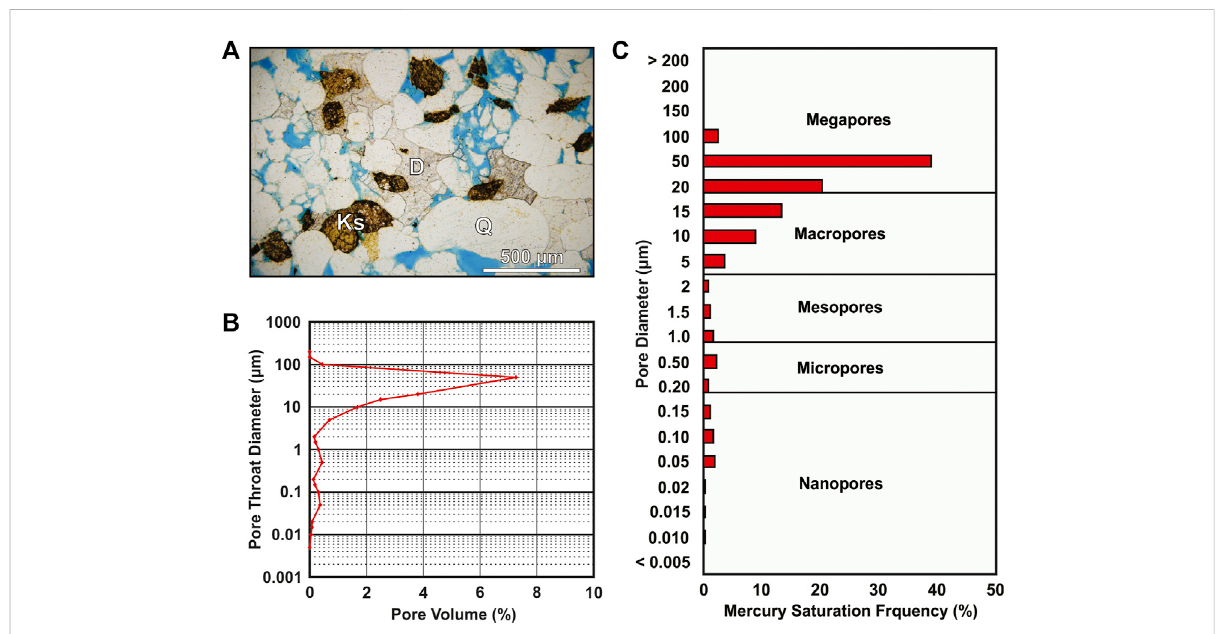
FIGURE 8 ThinsectionphotomicrographofacoreplugfromtheRoseRunfrom1,008.1 munderplanepolarlight,and (B) , (C) ,Mercury-InjectionCapillary Pressure (MICP) analysis of a core plug from 1,009.3 m. Core plug locations for the Rose Run in the KGS 1 Hanson Aggregates well are shown in Bowersoxetal.(2021,Figure5). (A). Mineralgrainsinthethinsectionareidenti fi edwithcapitalletters(Q,quartz;Ks,potassiumfeldspar;D,dolomite). Subrounded to rounded quartz grains show silica and potassium feldspar overgrowths and pressure dissolution at grain boundaries. (B) . MICP wasconductedforonecoreplugnearthebaseoftheRoseRuntocharacterizeporediameterdistribution.Thebulkoftheporediametersfallintothe macro-tomegaporerangesuggestingthatsupercriticalCO 2 maybeinjectedatrelativelylowerpressuresthanstratawhoseporesfallintothemeso- tonanoporerange.Themedianpore-throatradiuswas9.04 μ m,wellwithinthemacroporerange,andcoreplugpermeabilitywas289 mD. (C) .Most porevolumeintheKGS1HansonAggregates wellfallsinrangeof10 – 100 µm.Pore-throatdiameter versusporevolumesuggeststhattheRoseRun intheKGS 1HansonAggregateswell, pores withthroat diameters > 2 µm, wouldbecapableofoilandgasproduction inaconventionalhydrocarbon